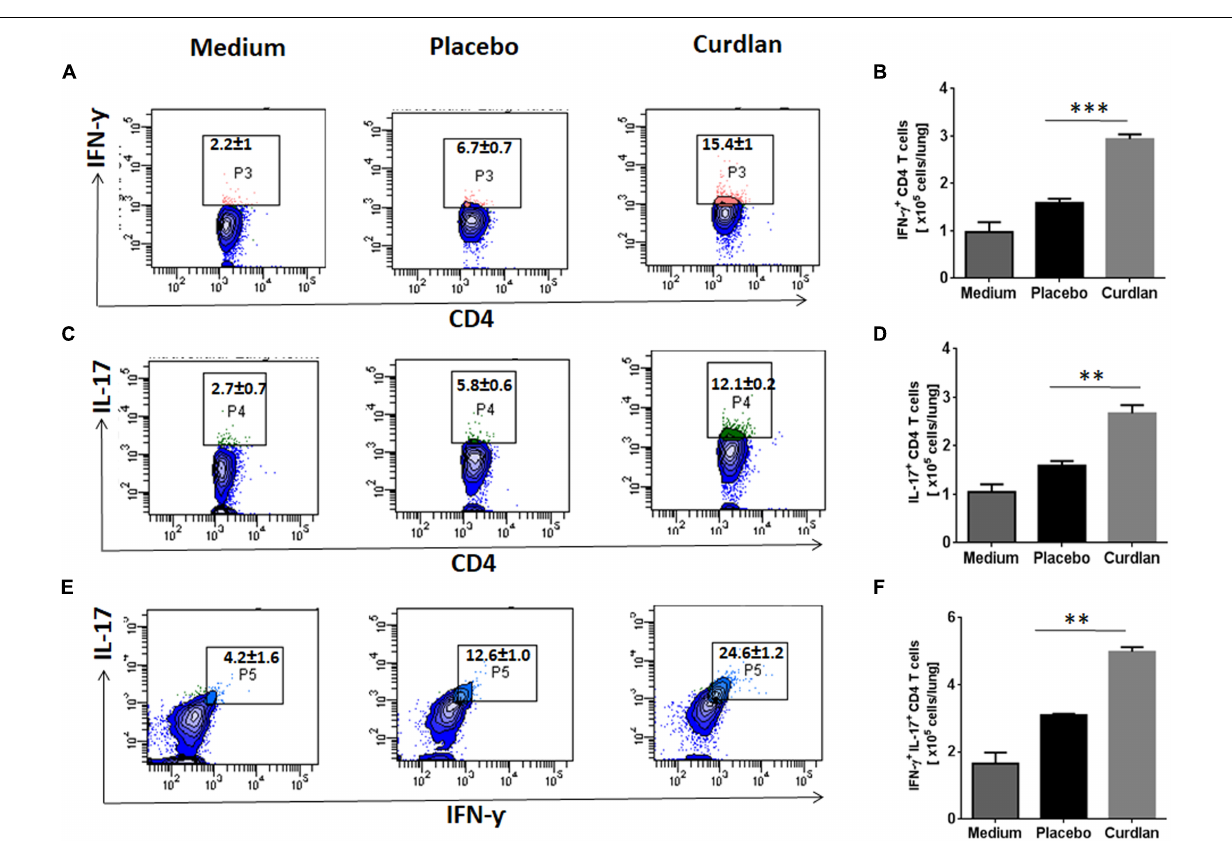
lesions as compared to placebo control ( Figure 4D